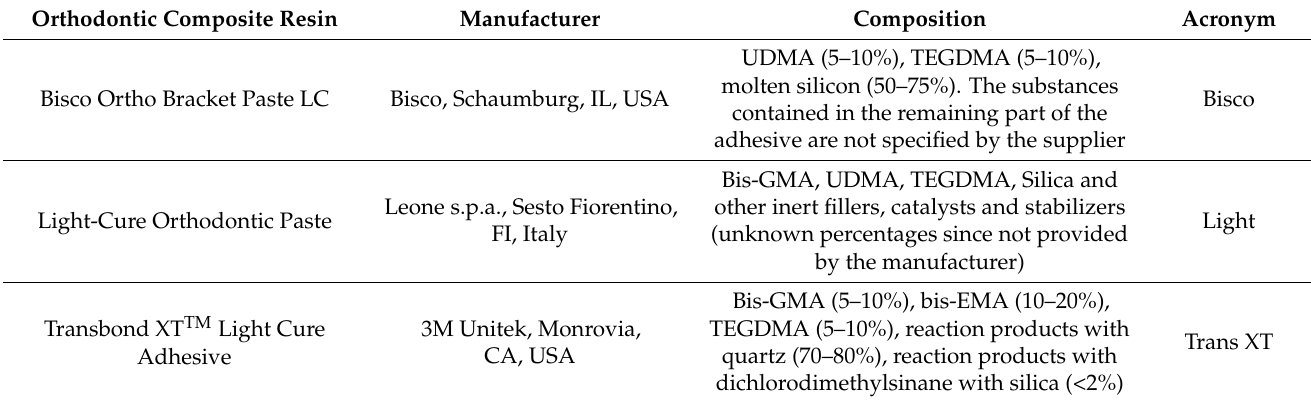
Table 1. The chemical compositions of the three light-cured orthodontic adhesive composites consid- ered for the study.